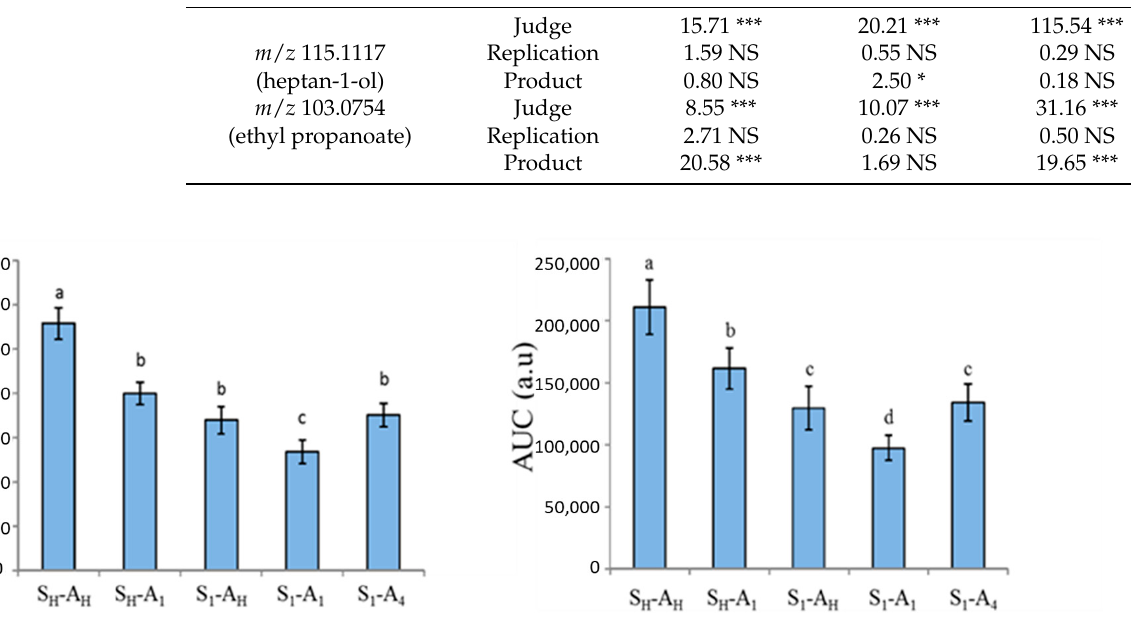
Table 2. Variables extracted from in vivo aroma compound release measurements (PTR-TOF-MS) obtained during the consumption of FLP for ions m / z 115.1117 (heptan-1-ol) and m / z 103.0754 (ethyl propanoate). Data were collected from each replication for each panellist. The T max values were calculated from the time at which the product was placed in the mouth. According to the F-ratio of the factor ANOVA: *, **, and *** indicate a significant product effect at p < 0.05, p < 0.01, and p < 0.001, respectively, and NS indicates a nonsignificant factor effect. AUC: area under the curve; Imax: maximum intensity; Tmax: time at which I max occurred. Ions Factor Imax Tmax AUC